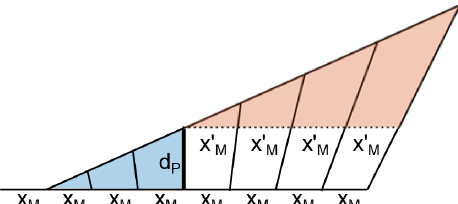
Figure 7. Schematic drawing of the shift of the best known dis- tance towards the border of the image array. The equations for the perspective correction can be adapted to the respective position of the best known